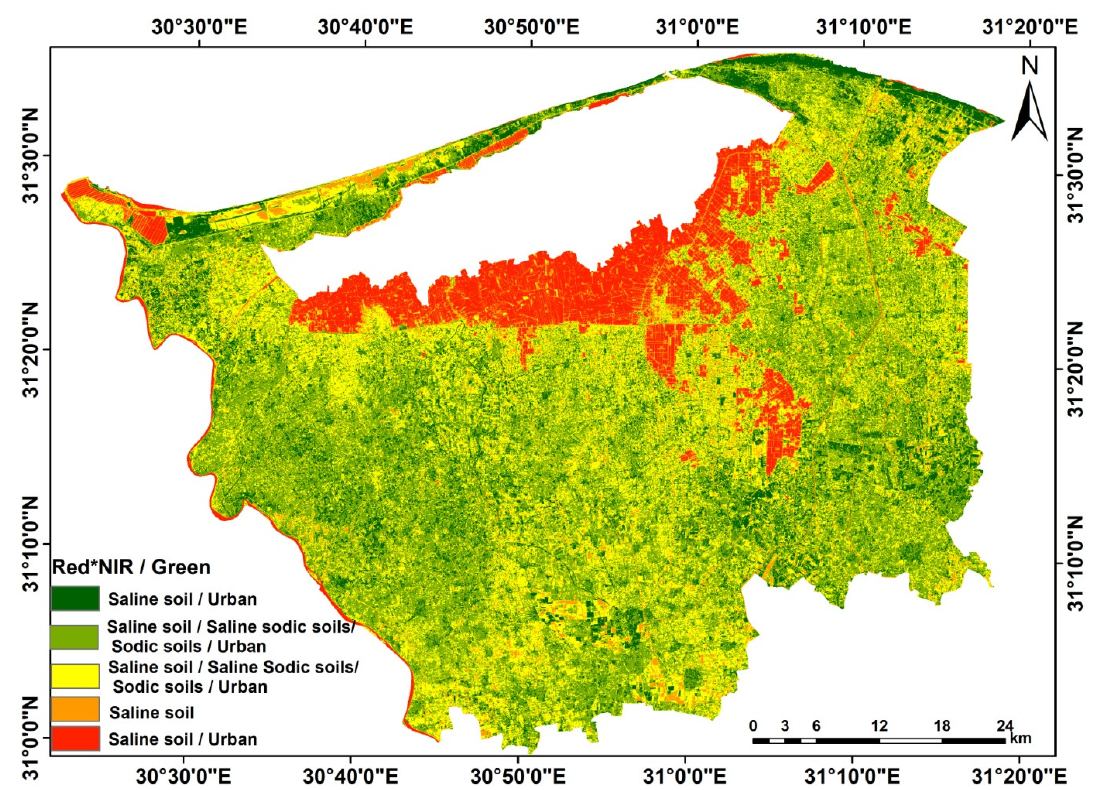
Figure 5. 2nd part of the equation (Red * NIR/Green) applied on 2021.